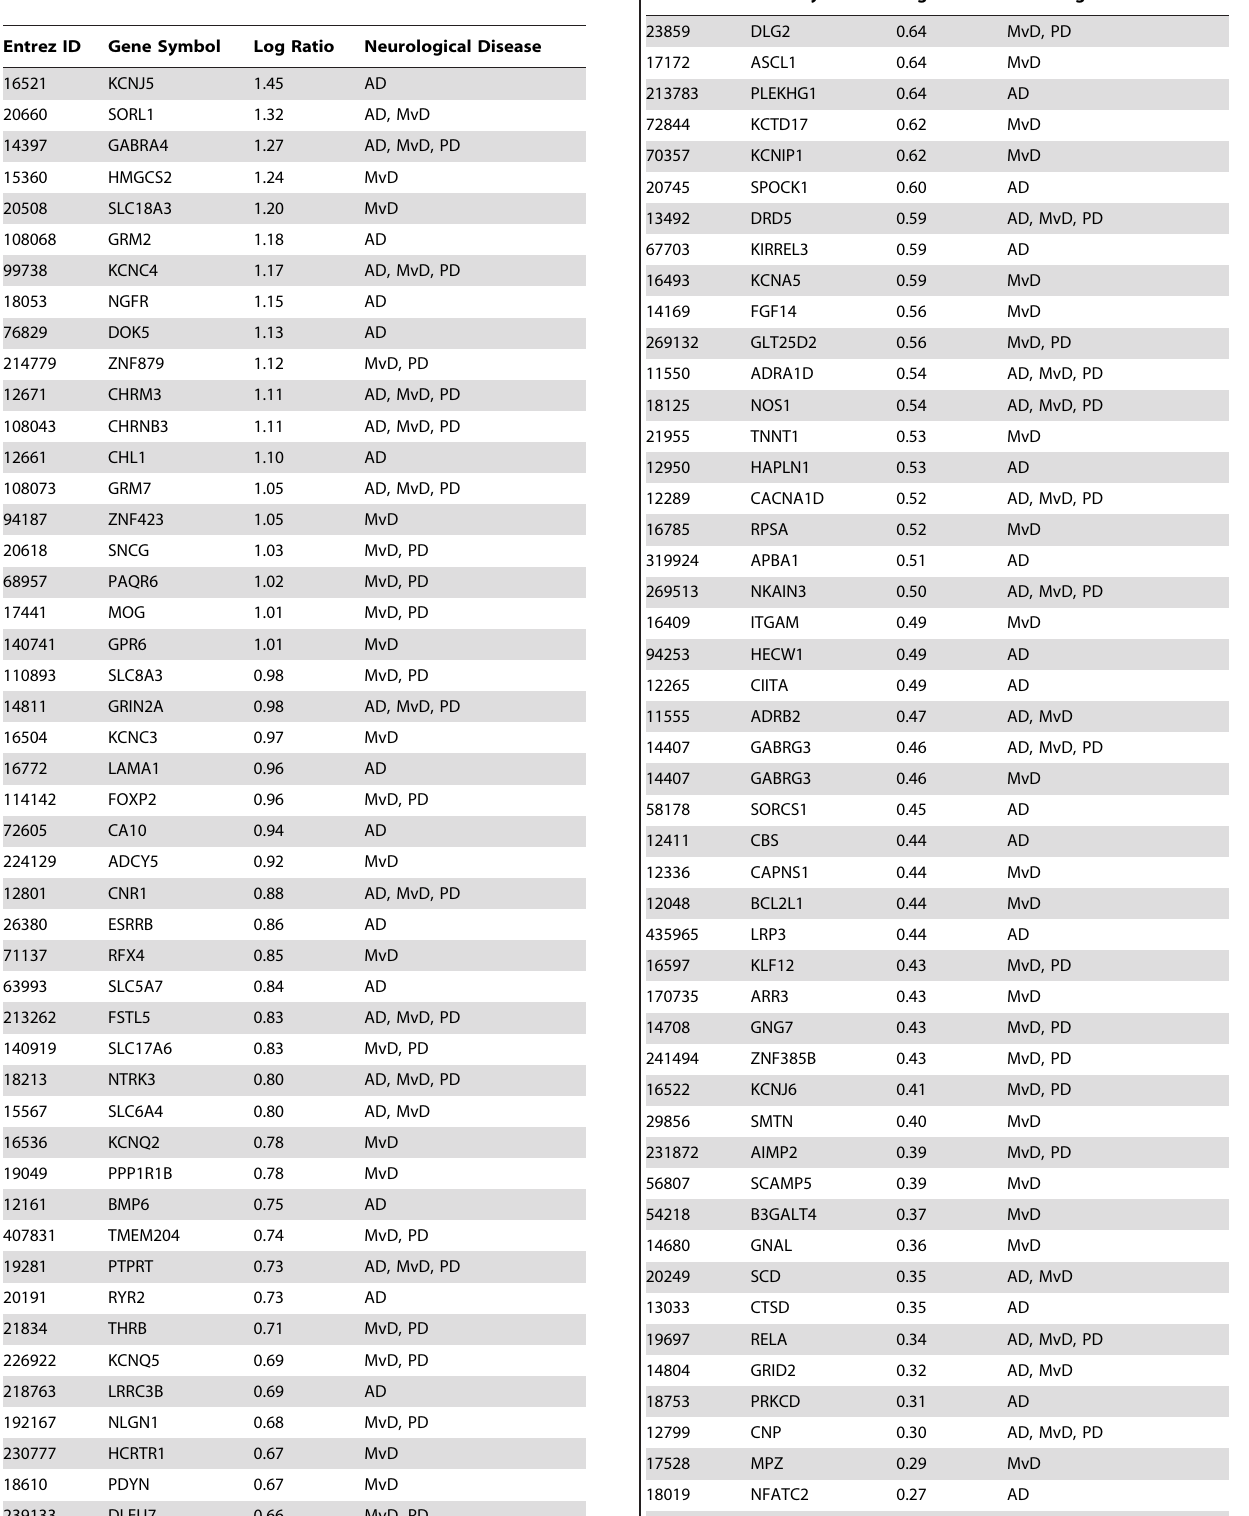
Table 4. The genomic candidates associated with three top- ranked neurological diseases: movement disorder (MvD), Alzheimer’s disease (AD) and Parkinson’s disease (PD).